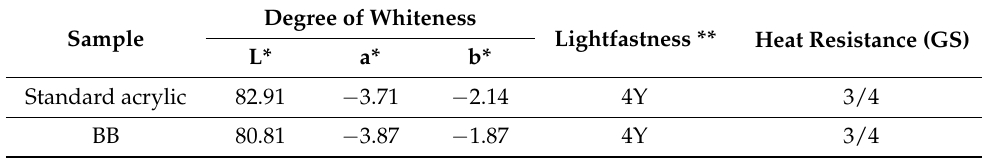
Table 6. Degree of whiteness and fastness tests.